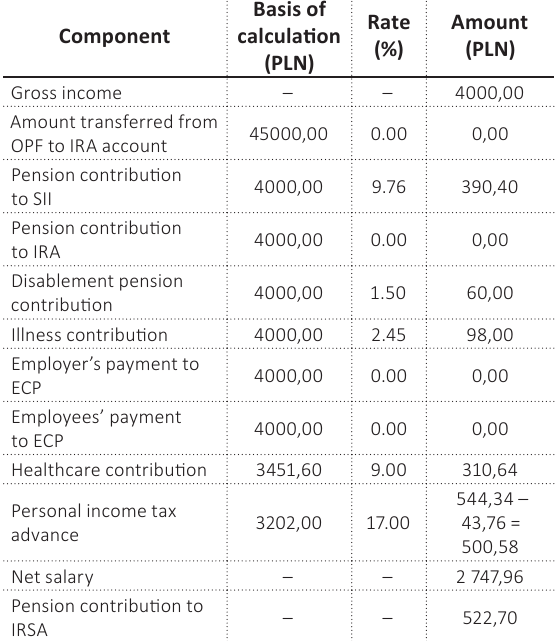
Table 10. Variant 3 – pension amounts after retirement